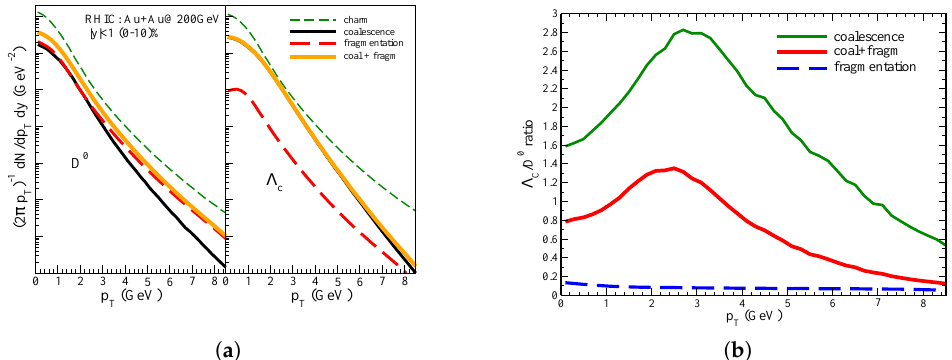
Figure 1. (Color online) ( a ) (left) Transverse momentum spectra at mid-rapidity for Au + Au collisions √ s = 200GeV and for (0%–10%) centrality for D 0 meson (left panel) and for Λ + c baryon (right at panel). ( b ) (right) Λ + c to D 0 ratio as a function of p T and at mid-rapidity for Au + Au collisions at √ s = 200GeV and for (10%–60%)